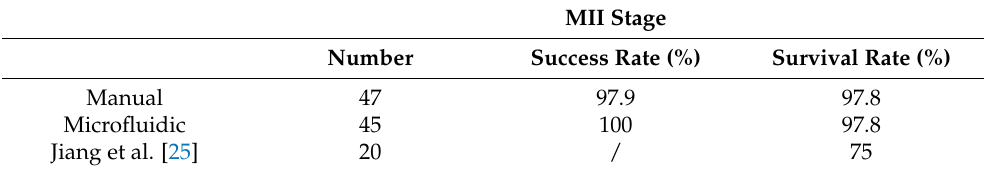
Table 2. Experimental results of mouse MII stage oocytes vitrification.